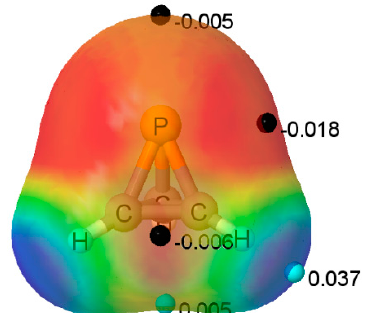
Figure 2. Molecular Electrostatic Potential (MEP) of P(CH) 3 on the 0.001 au electron density isosurface. The color coding ranges from red < − 0.01 au to blue > +0.04 au. The locations and values of local minima and maxima of interest on this surface are indicated by black and light blue dots, respectively.